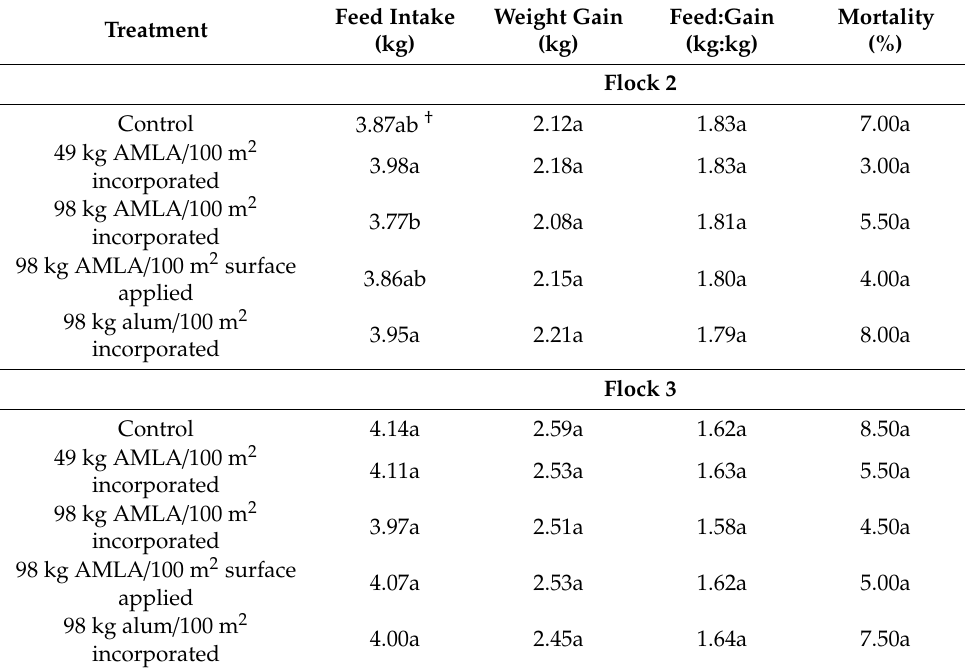
Table 1. E ff ect of amendments on broiler performance during flock 2 and